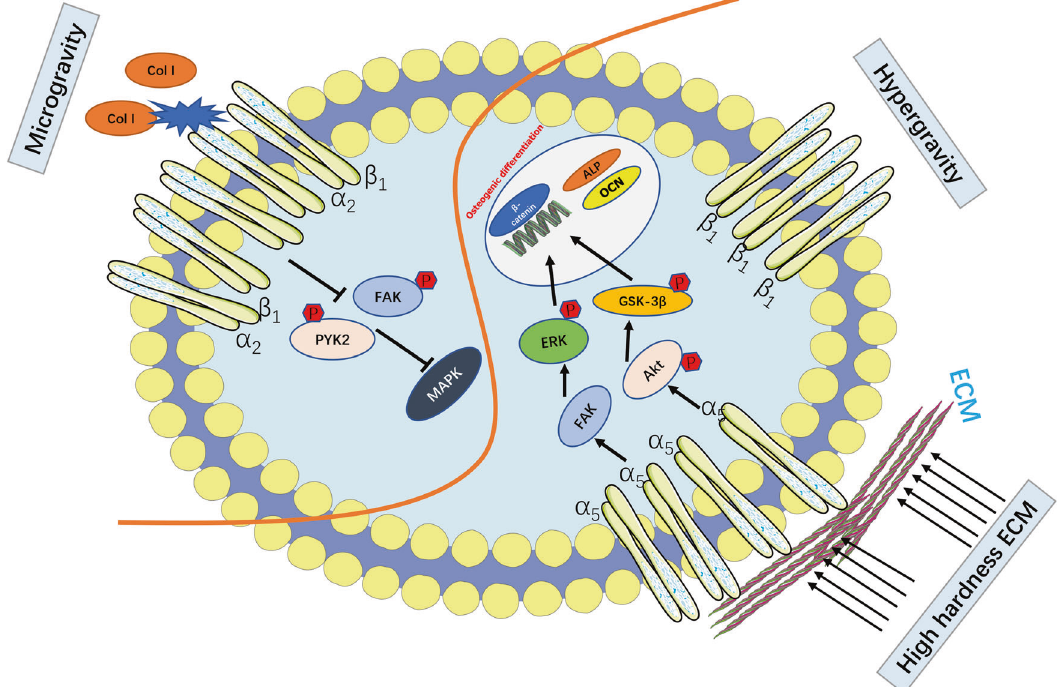
Fig. 4 Integrins mediate changes in the cellular microenvironment to regulate bone metabolism. Microgravity inhibits the binding of Col I to integrin α